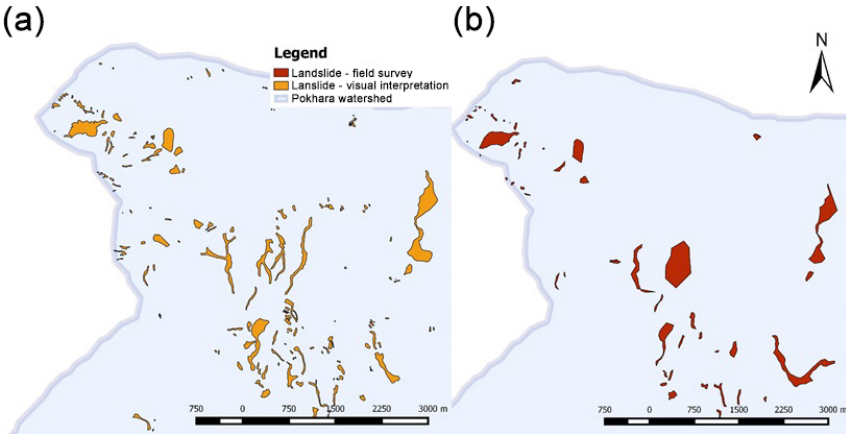
Figure 15. Maps of landslides created by using field survey (red polygons) and visual interpretation (orange polygons).